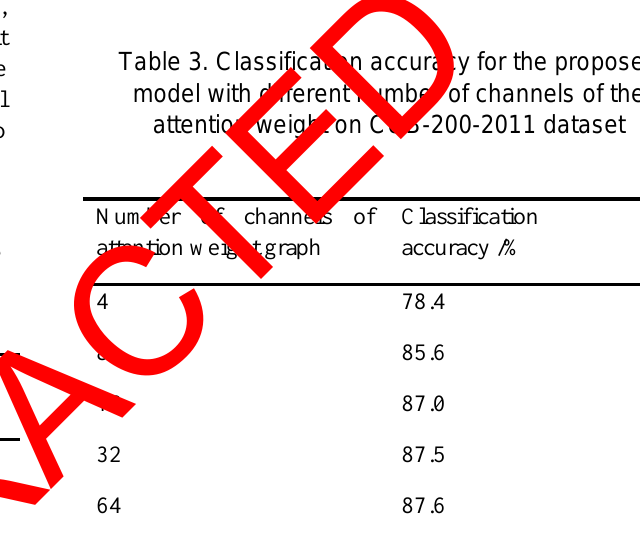
Table 3. Classification accuracy for the proposed model with different number of channels of the attention weight on CUB-200-2011